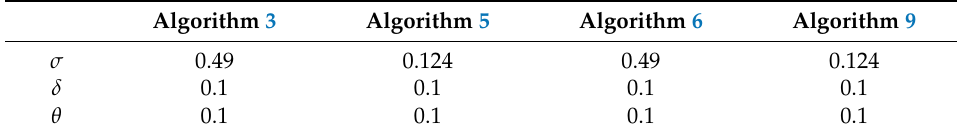
Table 2. Chosen parameters for each